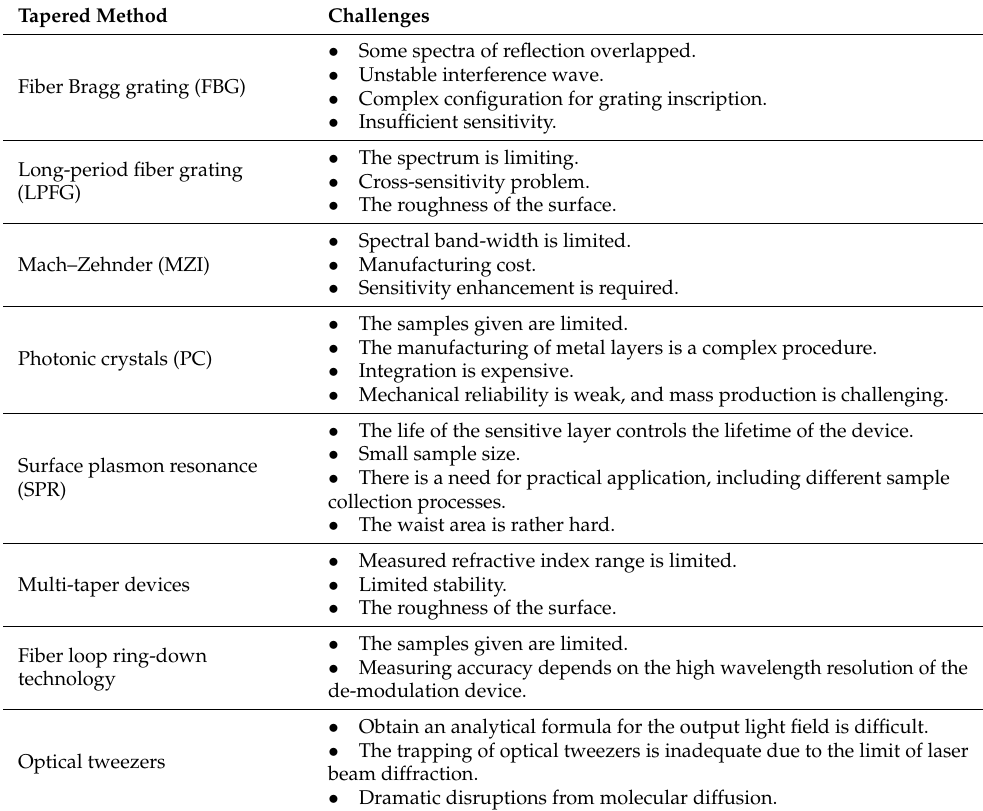
Table 2 summarizes the challenges of tapered fiber structures. Table 2. Shows the challenges of tapered fiber